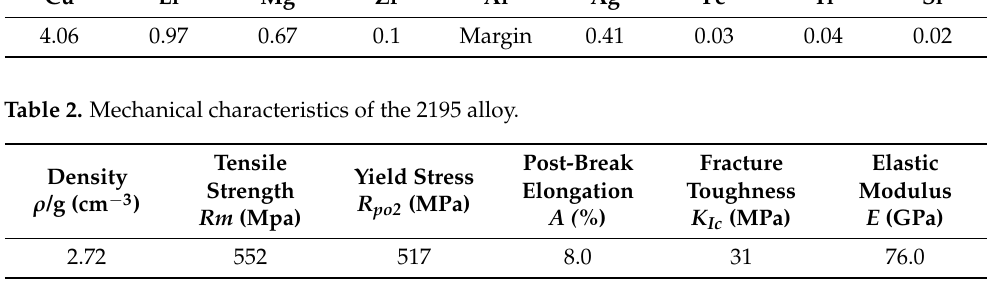
Table 1. Chemical composition of the 2195 alloy (wt%).